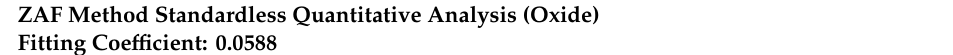
Table 8. Oxide of Kenaf ( Hibiscus cannabinus